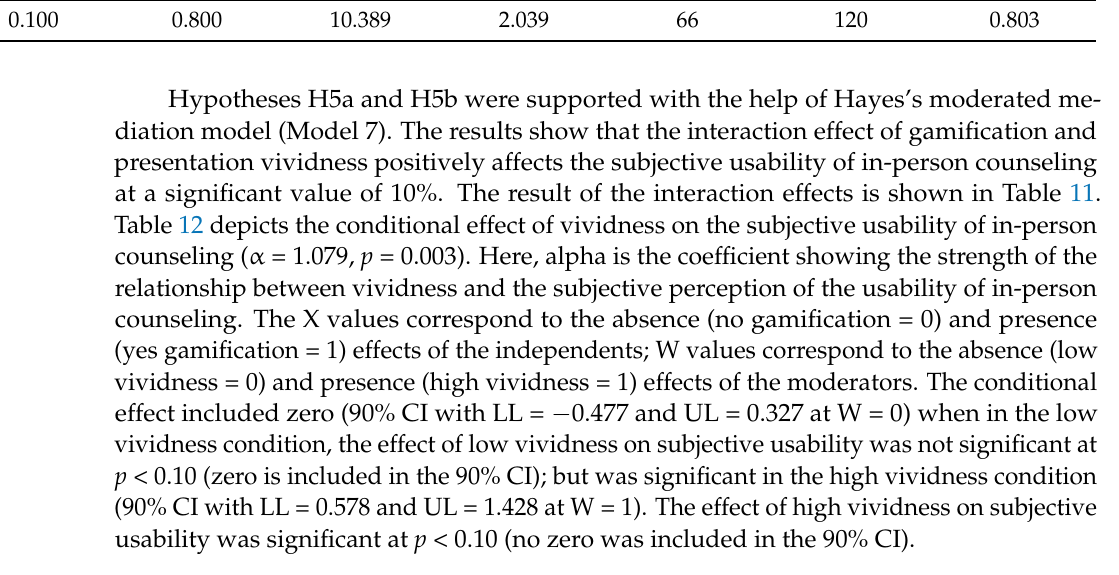
Table 11. Interaction effects of gamification and vividness on the objective and subjective usability of in-person